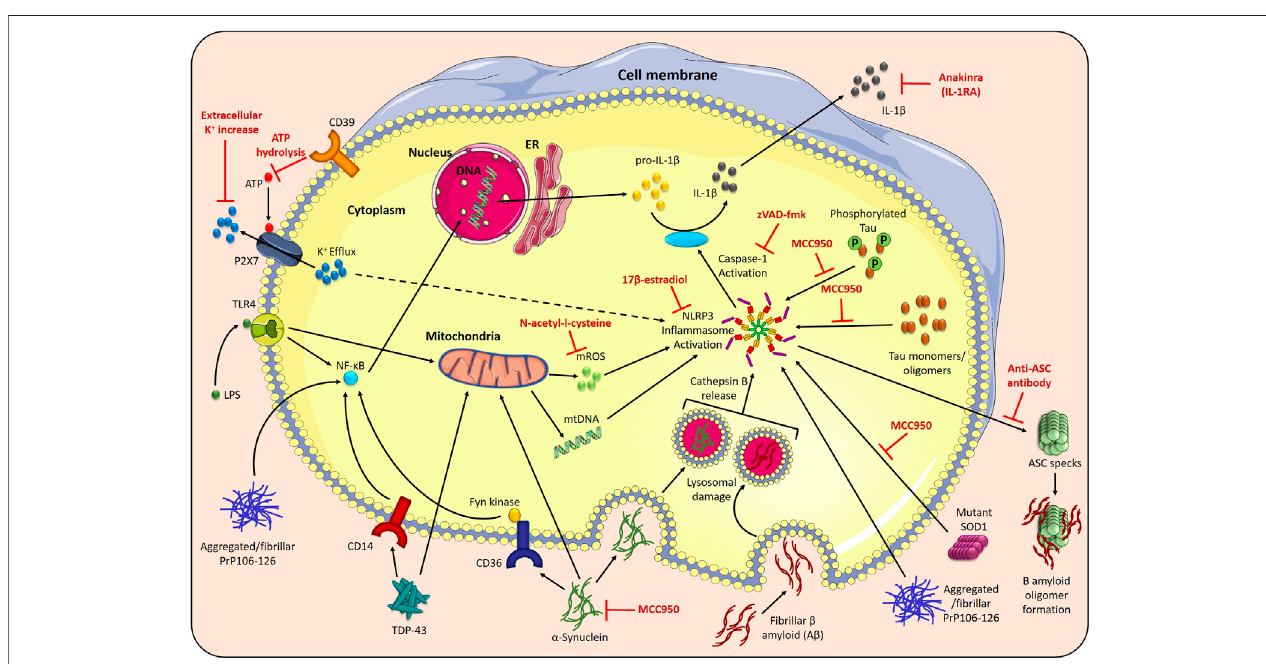
FIGURE2| NLRP3in fl ammasome activationinneurodegenerativedisorders.TheNLRP3in fl ammasomeassemblesinresponse totwosignals;toll-likereceptor4 (TLR4) stimulation by LPS induces the NF- κβ -mediated transcription of pro-IL-1 β and pro-IL-18, and stimuli such as P2X7 receptor-facilitated potassium (K + ) ef fl ux